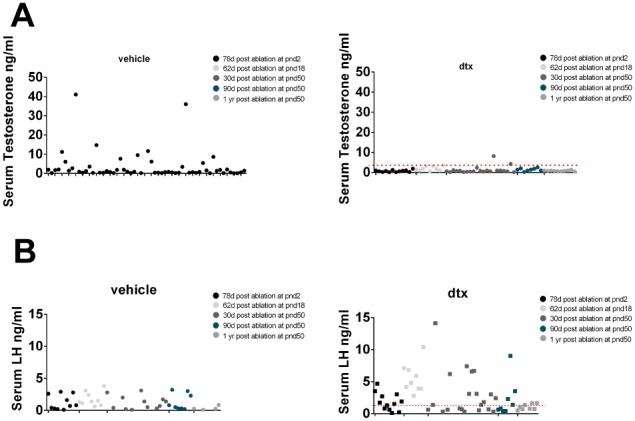
Changes in hormone pulsatility following SC ablation.Individual values for serum testosterone in vehicle-treated (A) and DTX-treated (C) animals. Individual values for serum LH in vehicle treated (B) and DTX treated (D) animals. Red dotted line indicates the mean of control animals. d,days; yr,year; dtx, injected with toxin; veh: vehicle control.